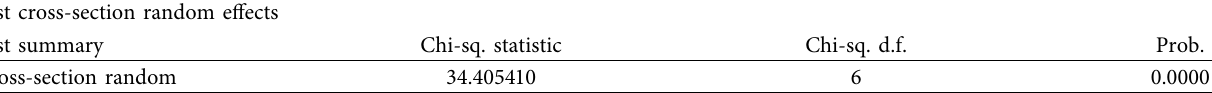
Table 4: Hausman test result.